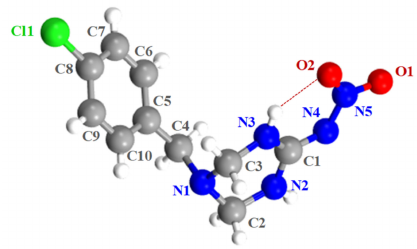
Figure 1. Crystal Structure of Compound 1 .